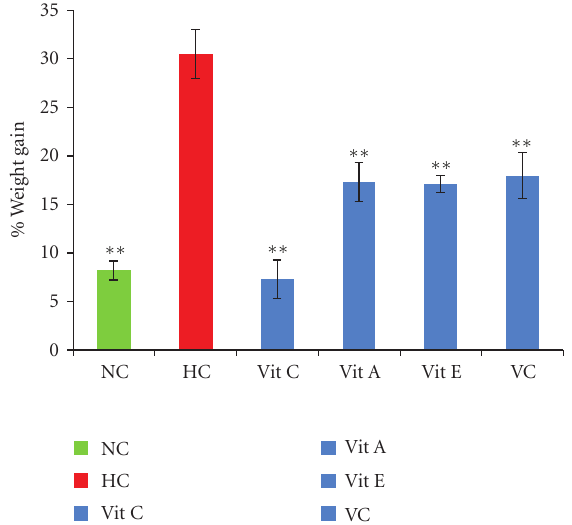
Figure 1: Percentage weight gain of salt-loaded rats supplemented with antioxidant vitamins. NC—normortensive control, HC— hypertensive control, Vit C—salt loaded treated with vitamin C, Vit A—salt loaded treated with vitamin A, Vit E—salt loaded treated with vitamin E, and VC—salt loaded treated with vitamins combined. ∗ P < 0.01 when compared with HC.